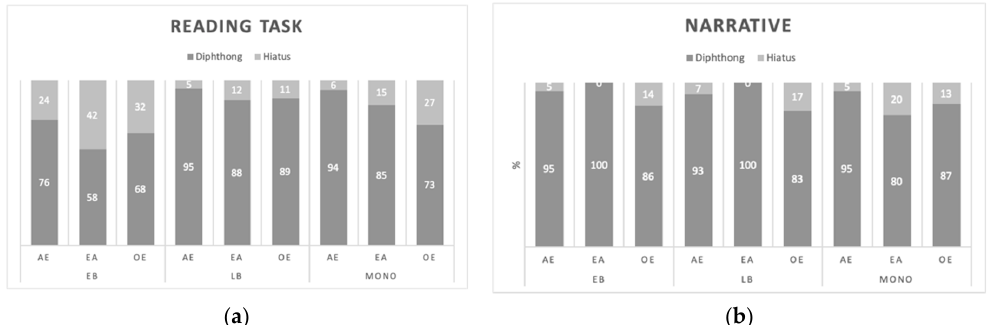
Figure 2. Percentage of diphthongs and hiatuses by type of vowel sequence and group (horizontal axis): ( a ) Reading task; ( b ) narrative.